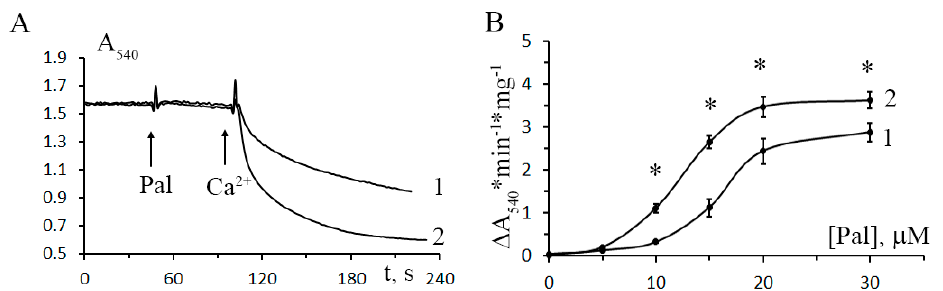
Figure 5. Effect of diabetes mellitus on the opening of palmitate/Ca 2+ -induced lipid pores in rat liver mitochondria. ( A ) Absorbance changes in the suspension of liver mitochondria of control (trace 1) and STZ-treated (trace 2) rats in response to the addition of 20 μ M palmitic acid (Pal) and 30 μ M Ca 2+ . ( B ) The rate of CsA-insensitive palmitate/Ca 2+ -induced swelling of liver mitochondria in control (curve 1) and diabetic (curve 2) rats versus palmitic acid concentration. The incubation medium contained 210mM mannitol, 70mM sucrose, 5mM succinate, 10 μ M EGTA, 1 μ M rotenone, 1 μ M CsA, and 10mM Hepes/KOH buffer, pH 7.4. Additions: 30 μ M Ca 2+ . The concentration of mitochondrial protein was 0.4 mg/mL. Values are given as means ± SEM ( n = 5). * p < 0.05 compared to controls.